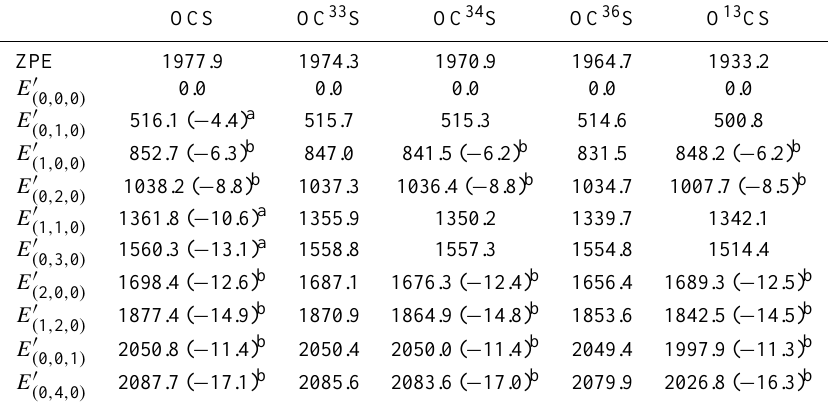
Table 1. Vibrational excitation energies given in cm − 1 for the different isotopologues, with E 0 ( calc ) − E 0 ( obs ) with observed values taken from Belafhal et al. (1995) and Zuniga et al. (2000). ZPE is the calculated zero point are E 0 i i vibrational energy.